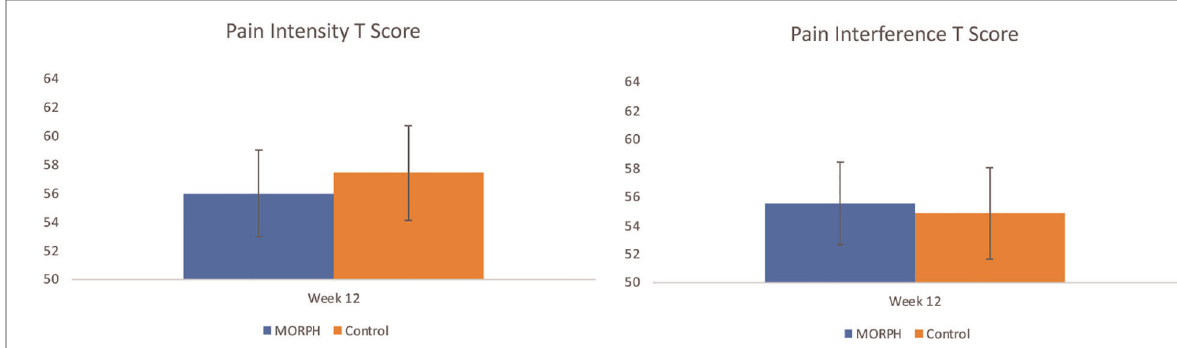
FIGURE 5 Baseline-adjusted pain intensity and pain interference T scores at week 12.